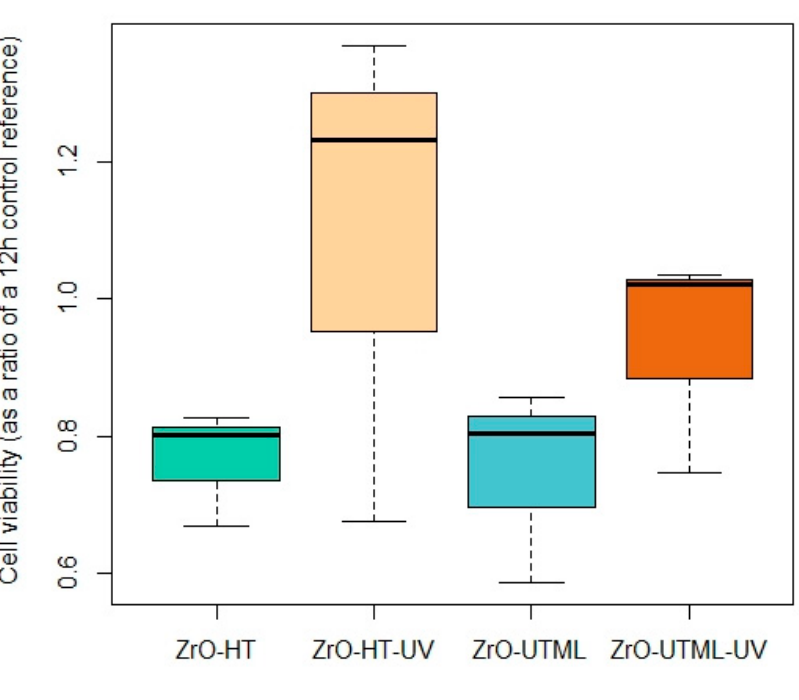
Figure 5. Cytotoxicity assessment as a ratio of the 12th hour control reference for the four groups included in the study.